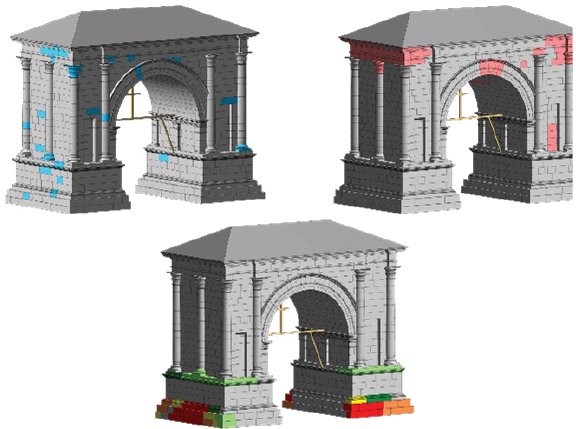
Figure 5: In the different filtered representations, colors are connected to Sampled Ashlars (top left), restored ashlars(top right), risk assestment (bottom).